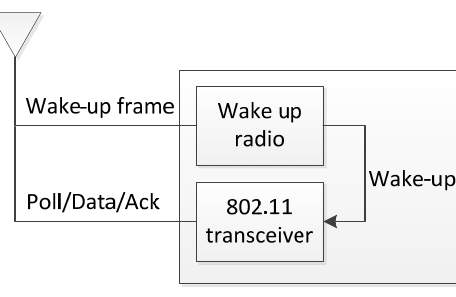
Figure 1. Structure of the Wake-up radio device. Ack = acknowledgment.